Question: What type of chart is this?
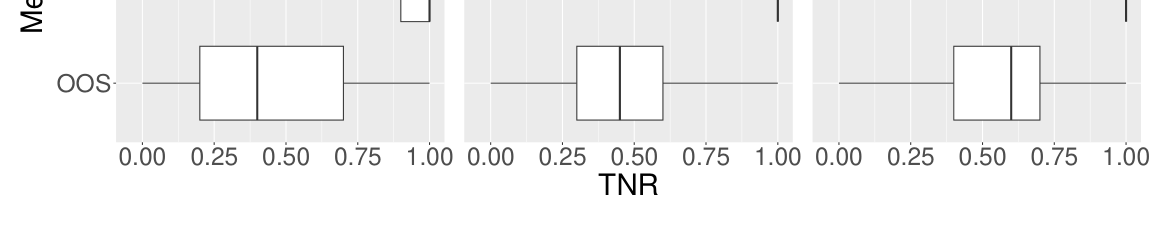
Answer: box